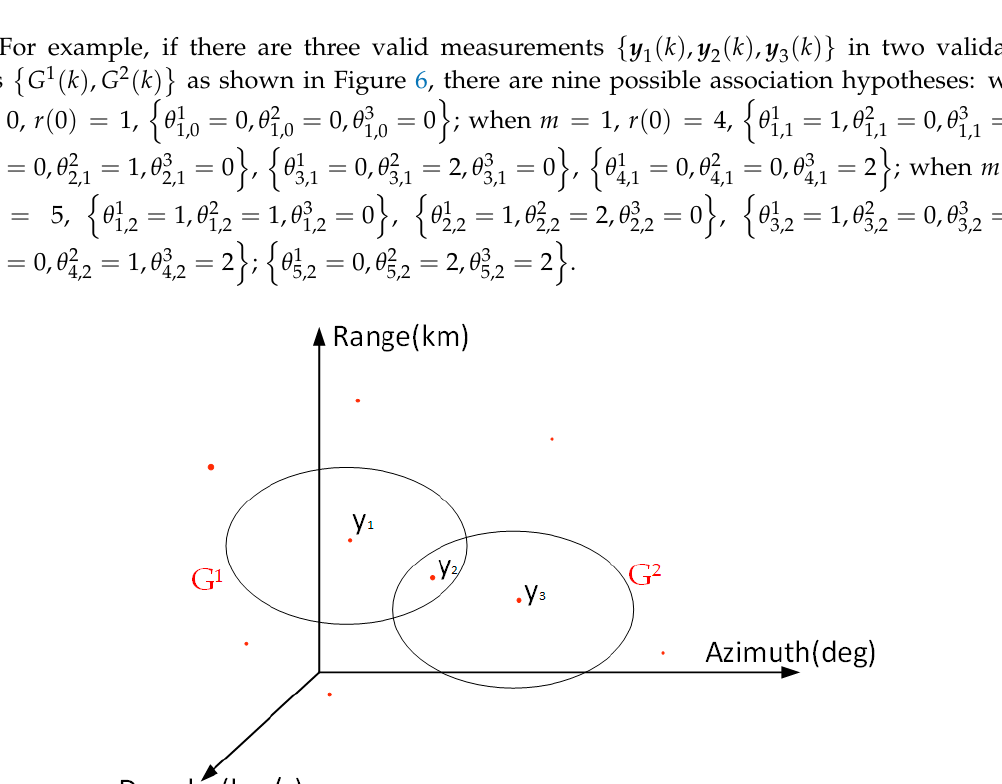
Figure 6. Illustrative gating scenario in azimuth-range-Doppler space with two propagation modes and three validated measurements.